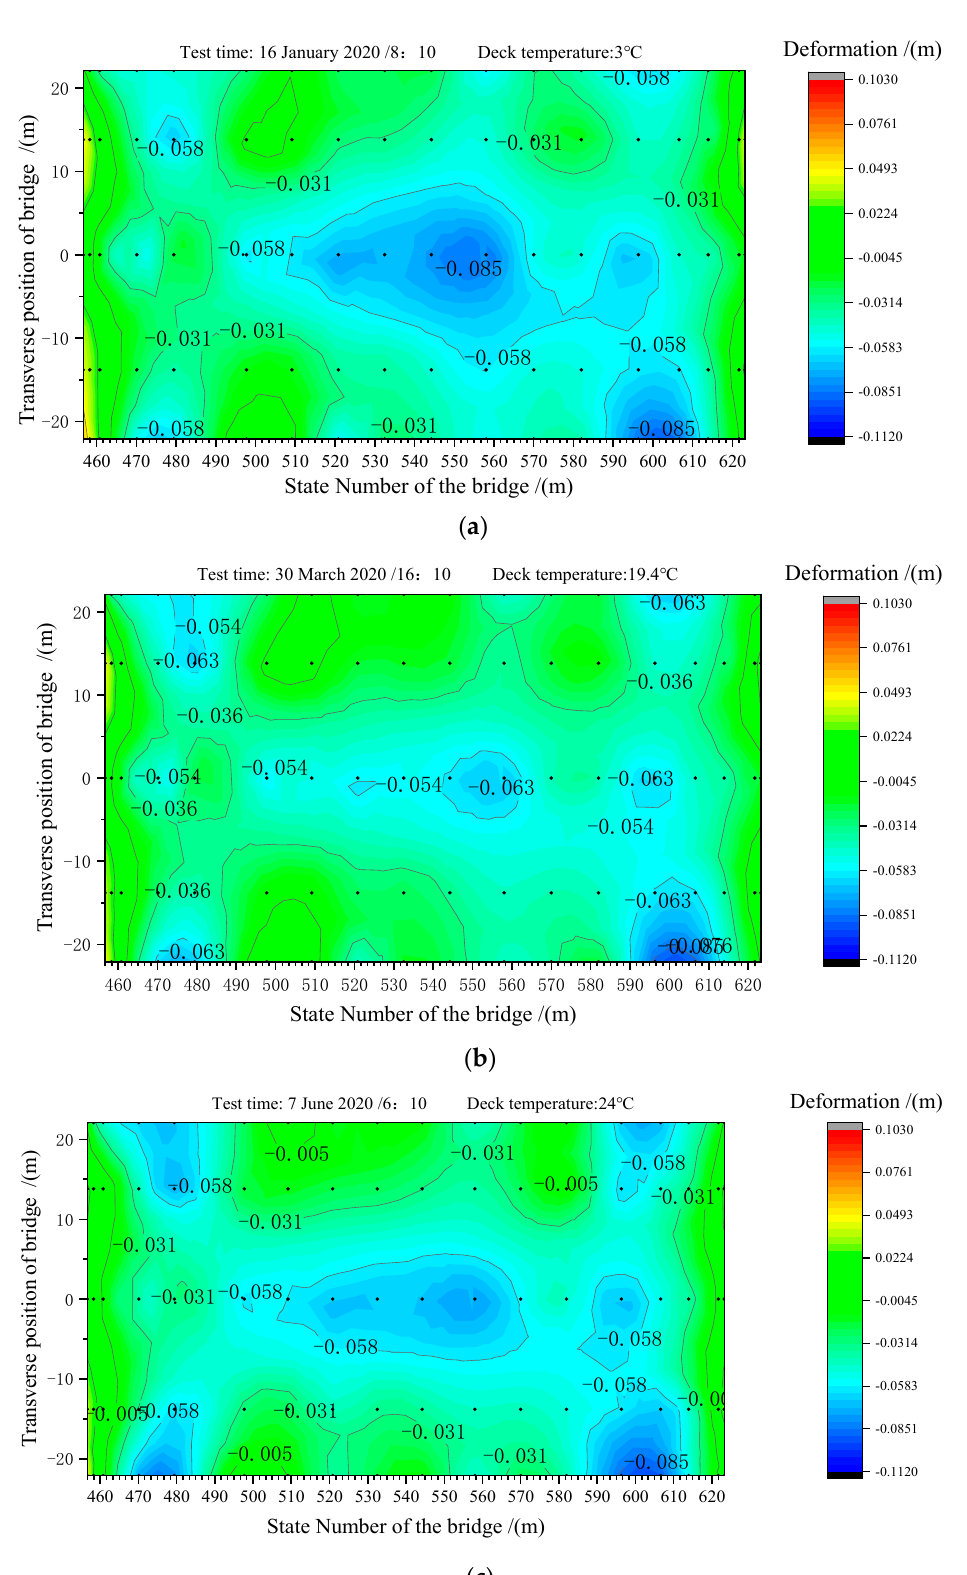
Figure 35. Long-term monitoring of the deformation at different temperatures of different times. ( a ) Test result on 16 January 2020, 3. ( b ) Test result on 30 March 2020, 7. ( c ) Test result on 7 June 2020.